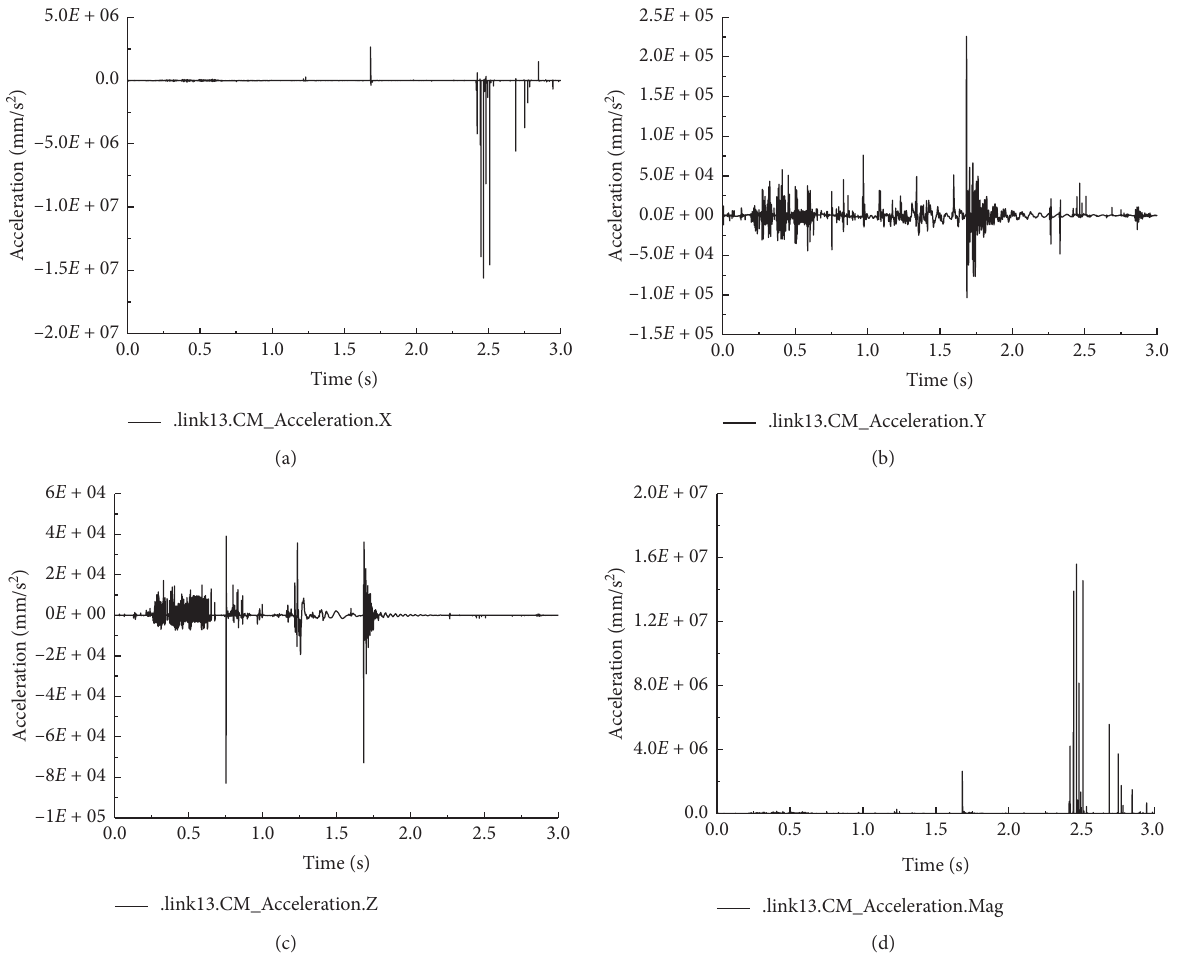
Figure 14: Link acceleration change curve at the chain blocked position. (a) Acceleration in the X direction. (b) Acceleration in the Y direction. (c) Acceleration in the Z direction. (d) Acceleration